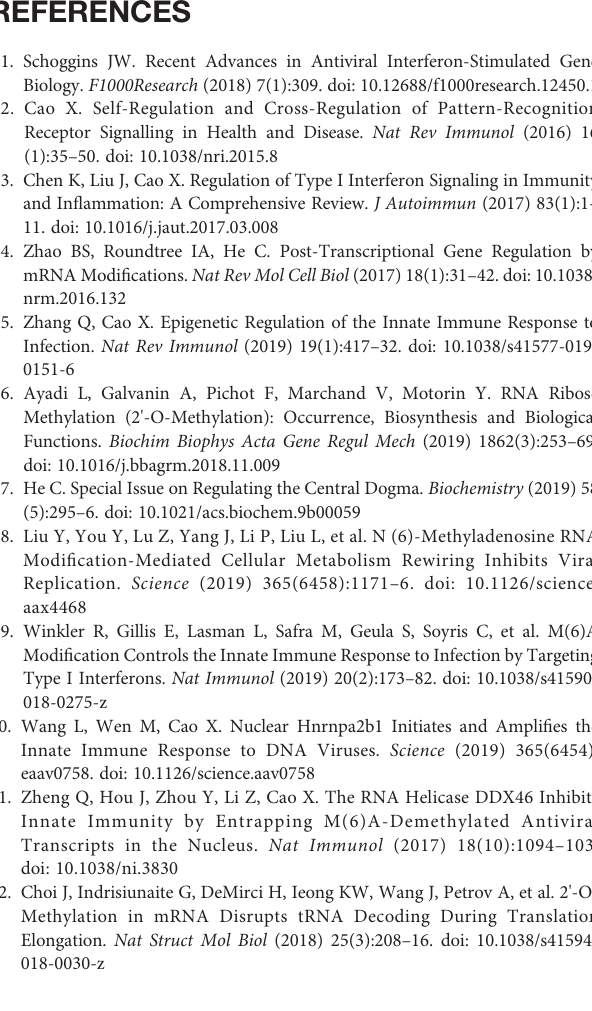
Supplementary Figure 4 | RNA 2 ′ -O-methyltransferase FBL facilitates viral infection (A) CRISPR/Cas9 strategy used to knockout the second to fi fth exon of Fbl in mouse macrophage cell line; (B) Veri fi cation of FBL deletion in Fbl +/- RAW264.7 cells by PCR followed by DNA gel electrophoresis; (C) Veri fi cation of FBL deletion in Fbl +/- RAW264.7 cells by Western blot; (D) Schematic diagram of the gene elements driving the expression of Cas9; (E) RT-qPCR of FBL sgRNA in